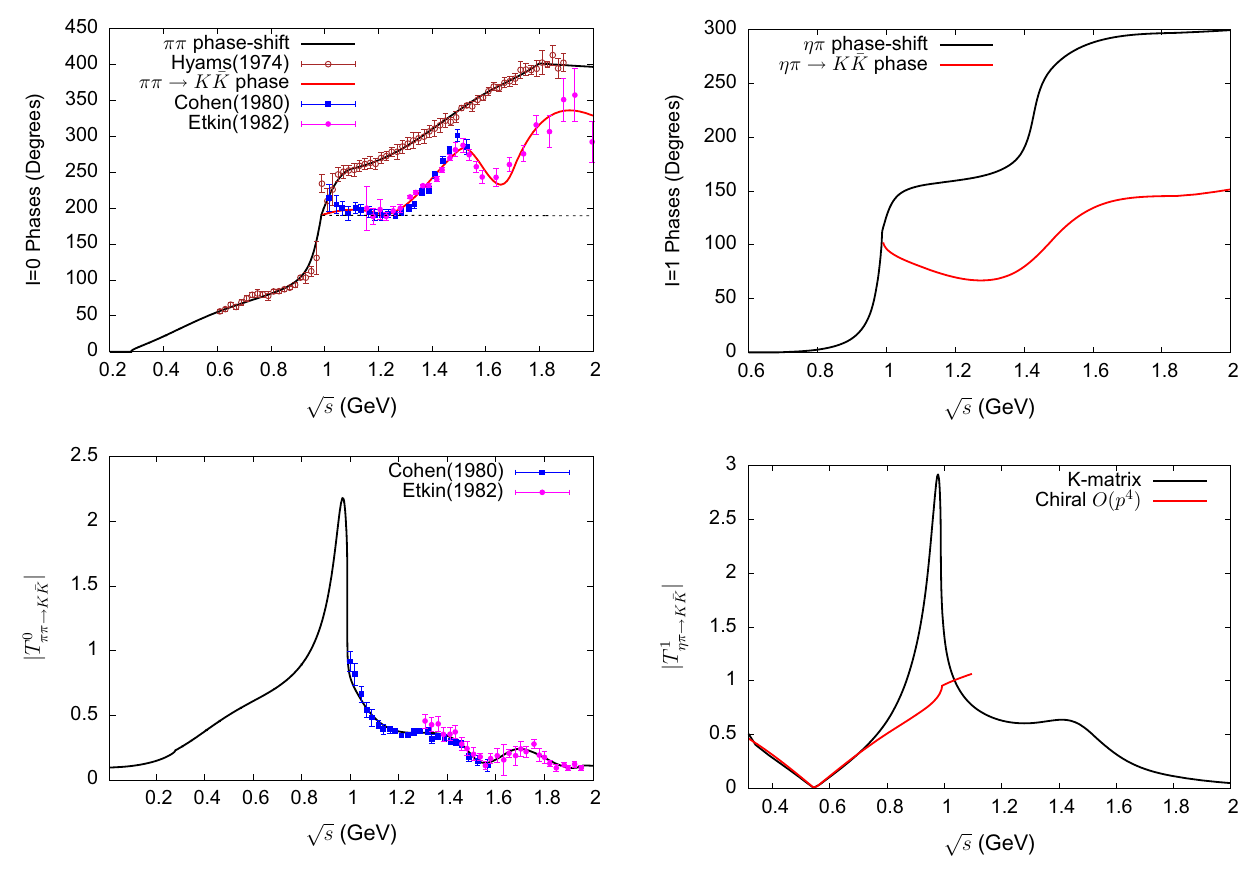
(minus 0 , which is also 0